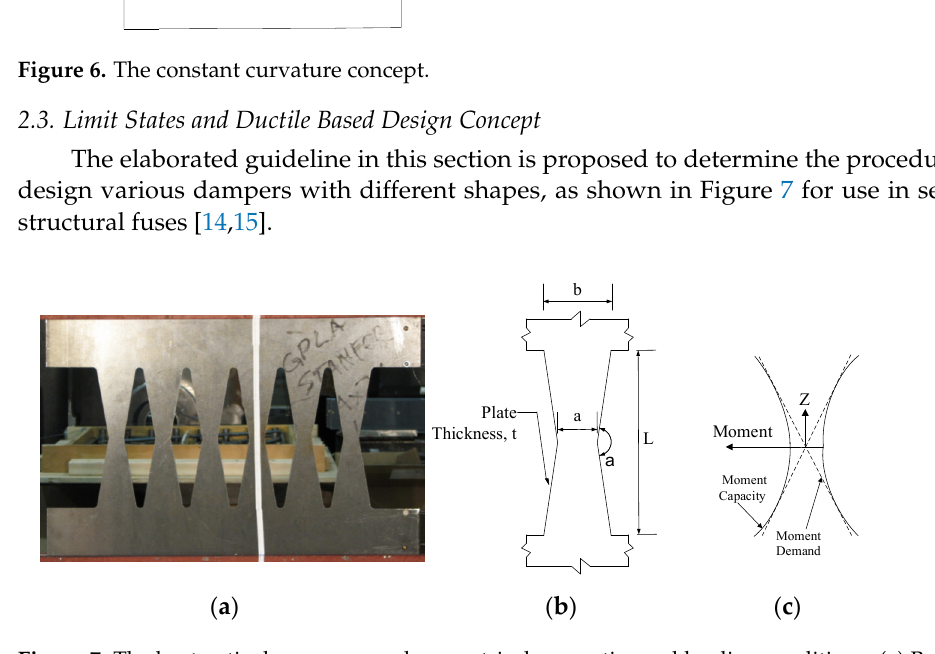
Figure 7. The hysteretic damper general geometrical properties and loading conditions. ( a ) Butterfly-shaped Plate; ( b ) Geometry of a damper; ( c ) Moment Diagram.